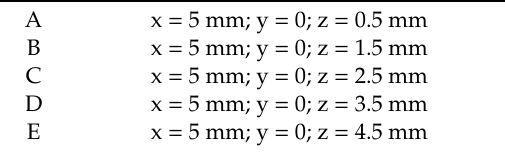
Table 3. Coordinates of the measured points using